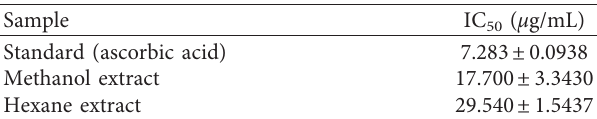
Table 3: IC 50 of DPPH radical scavenging activity for the methanol and hexane extracts of V. camporum and ascorbic acid.